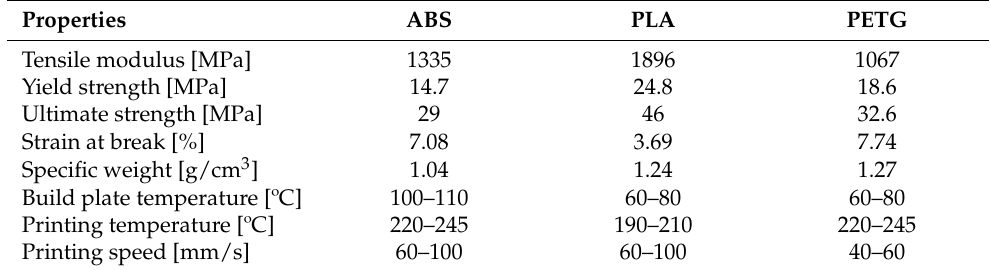
Table 2. Typical materials properties values and printing parameters used with FDM printers.